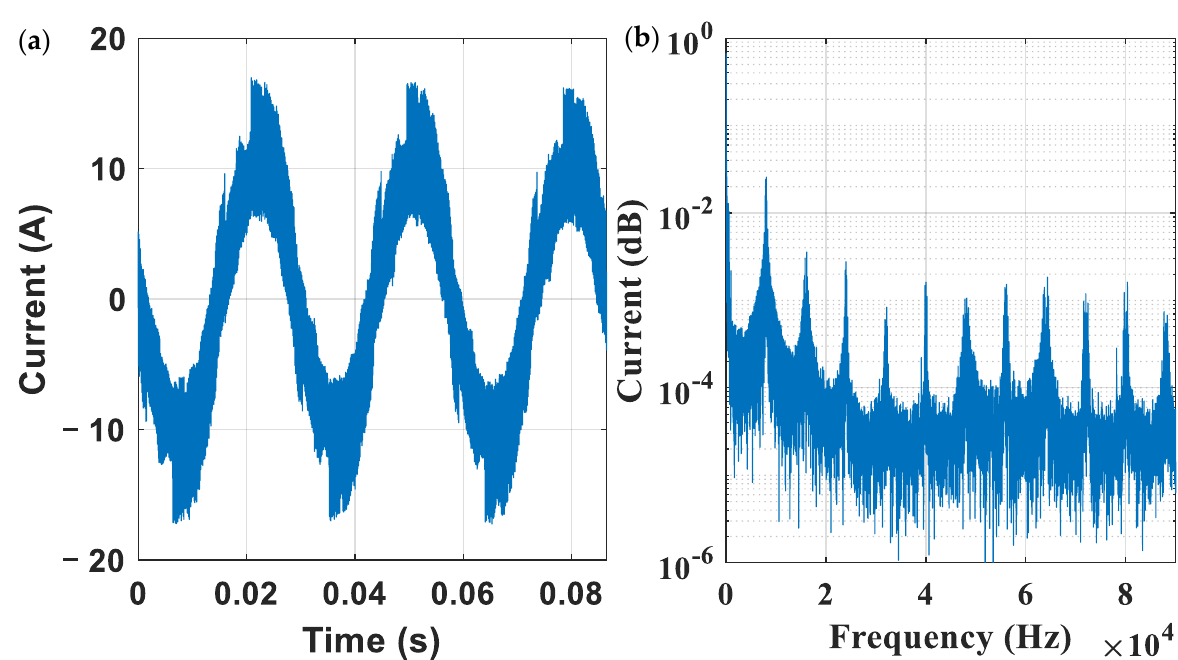
Figure 6. Block diagram of the frequency analysis.